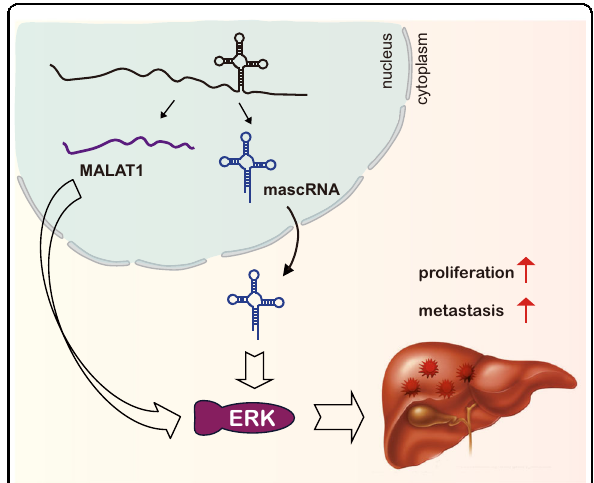
Fig. 8 mascRNA and its parent lncRNA MALAT1 can both promote cell proliferation and metastasis of HCC cells by activating ERK/MAPK signaling. Schematic overview of mascRNA and MALAT1 in